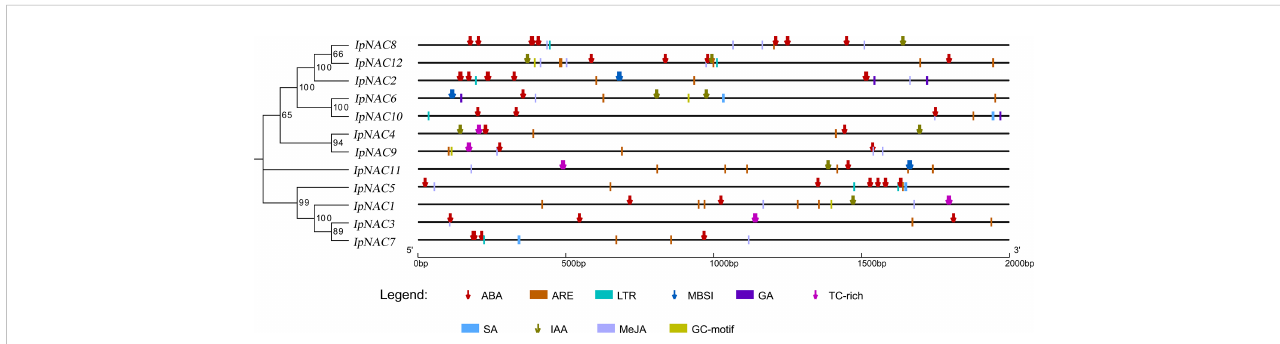
FIGURE 3 Cis-elements in the 2 kb upstream promoter of Ipomoea pes-caprae IpNACs . The homologous tree of the IpNAC genes is located on the left, and the number at the node indicates the bootstrap value. Symbols of different colors and shapes mark the relative positions of different elements, and the black scale line represents the relative protein length.